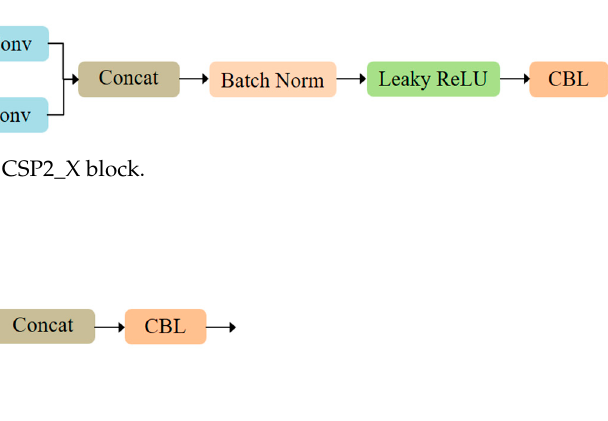
Figure 8. Composition of the SPP block .